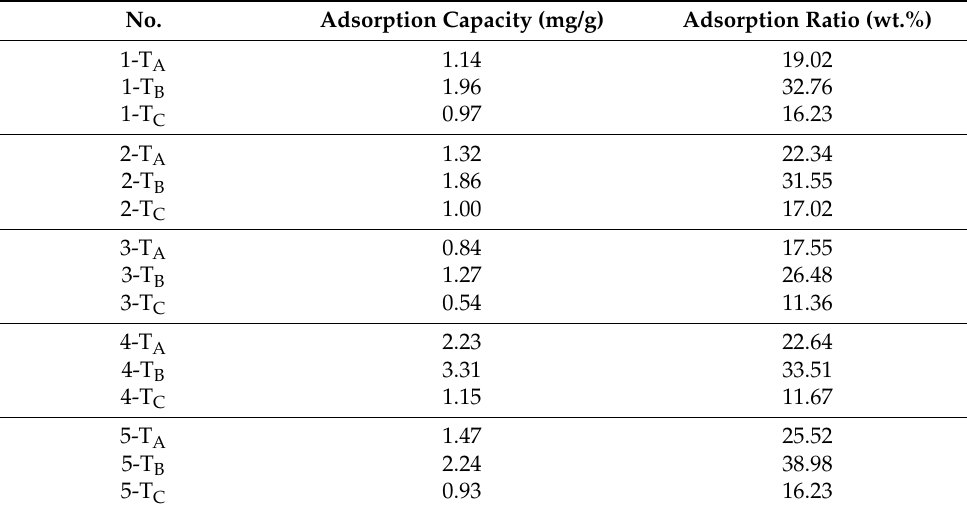
Table 3. The date of adsorption capacity and adsorption ratio. No. Adsorption Capacity